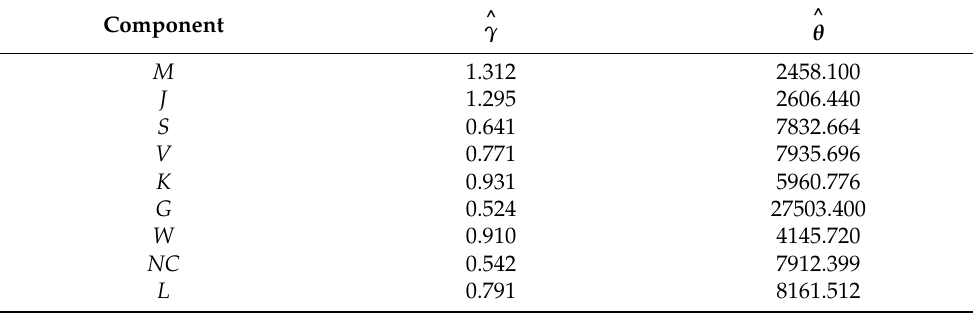
Table 4. Model parameter of failure rate of each component of machining center.